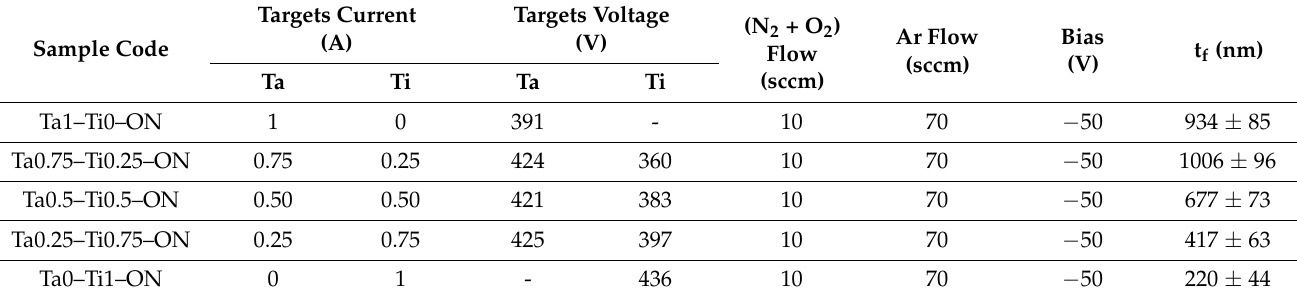
Table 1. Values of the experimental parameters used to deposit by reactive magnetron co-sputtering films belonging to the TaTiON system (t f = thickness of the